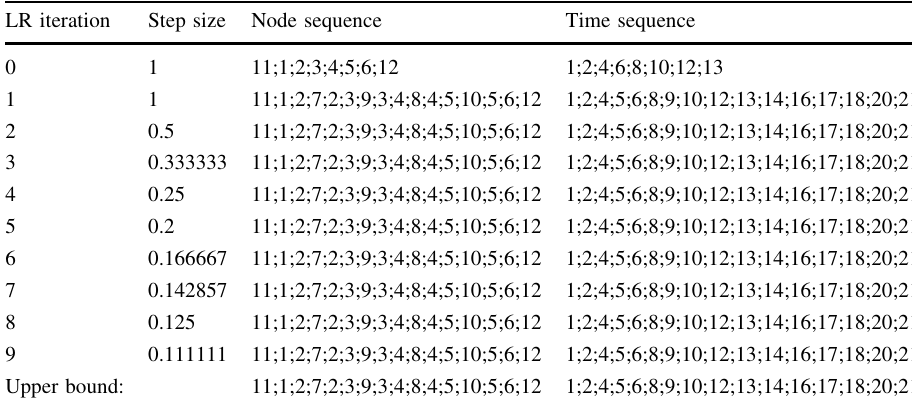
Table 7 The evolution of path node sequences and path time sequences for basic example with extended link travel